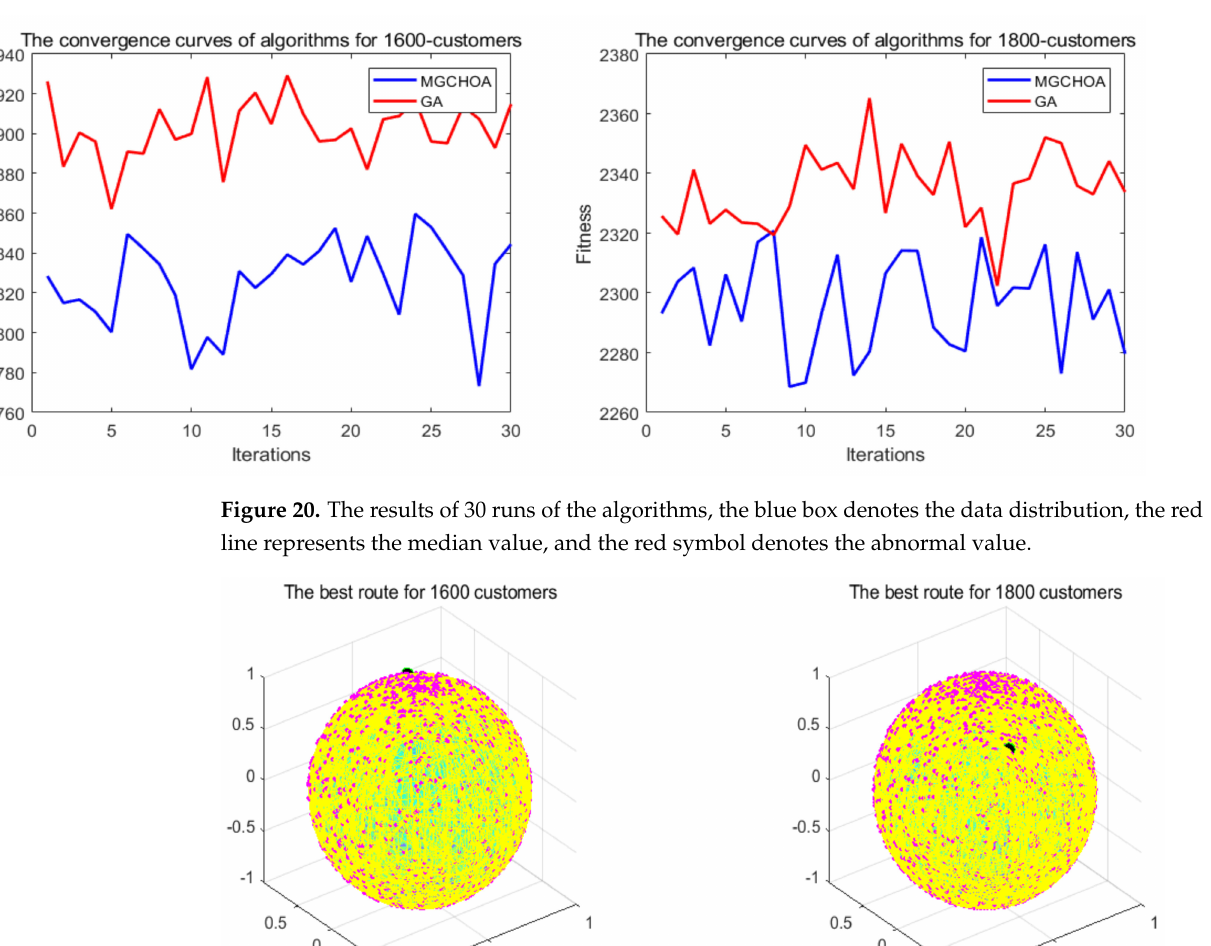
Figure 19. The ANOVA tests of the results after 30 runs, the blue box denotes the data distribution, the red line represents the median value, and the red symbol denotes the abnormal value.